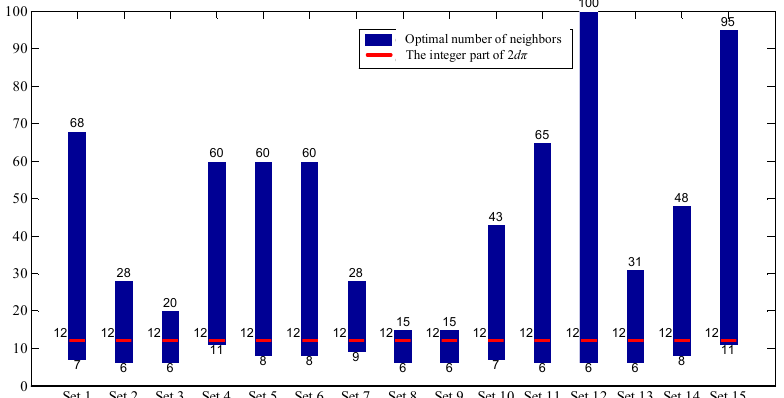
Figure 9. The solved range of the number of neighbors in 15 datasets.